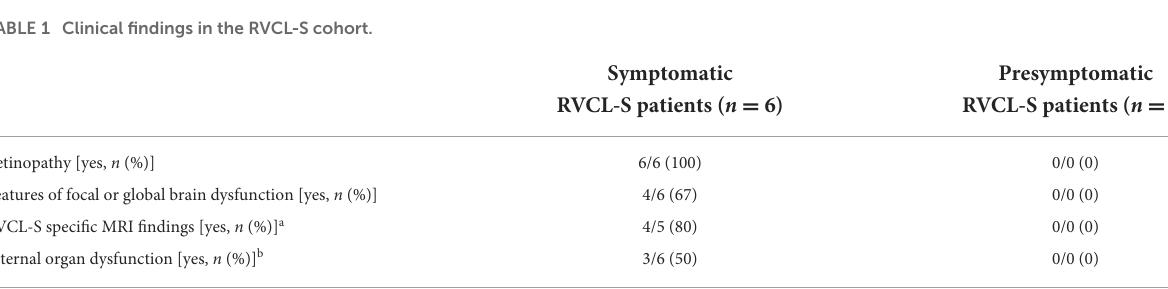
TABLE 1 Clinical findings in the RVCL-S cohort.